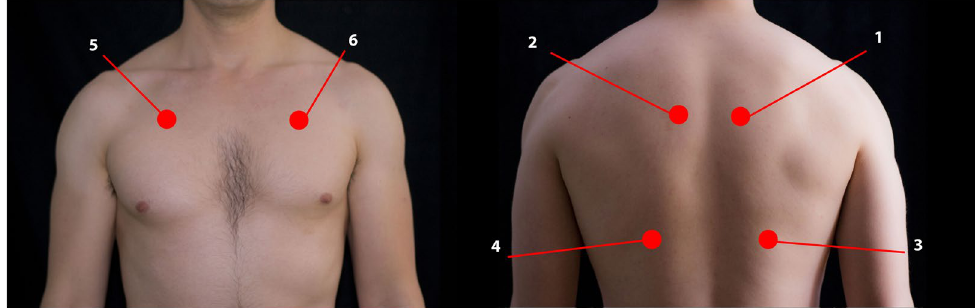
Figure 2. Illustration showing the different places where lung sounds were recorded. (1_2) Between the spine and the medial border of the scapula at the level of T4–T5; (3_4) at the middle point between the spine and the mid-axillary line at the level of T9–T10; (5_6) at the intersection of the mid-clavicular line and second intercostal